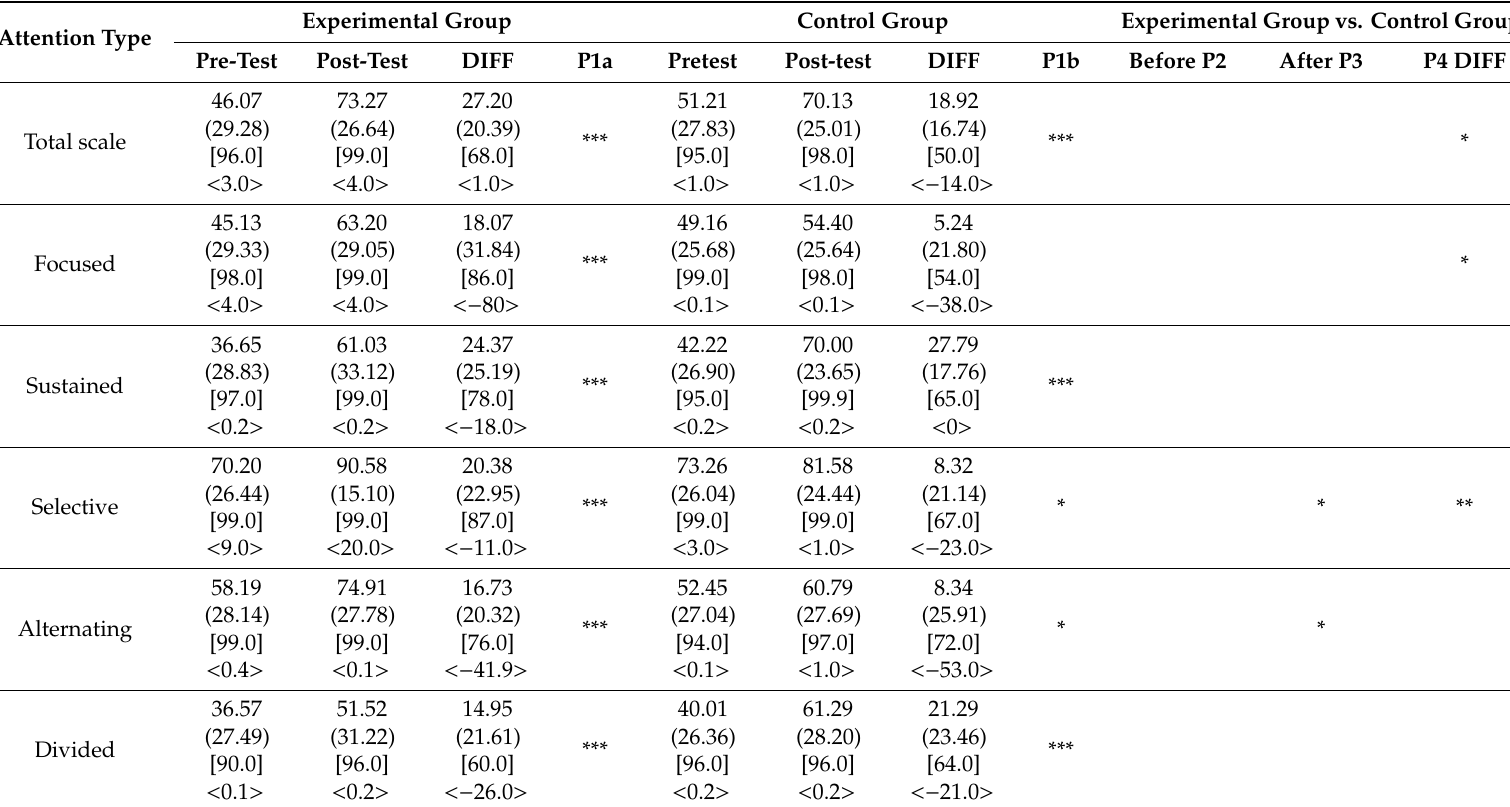
Table 3. Questionnaire results. The percentile rank data are represented as mean, SD (in parentheses), maximum (in bold parentheses, []) and minimum percentile rank (in angle brackets, <>